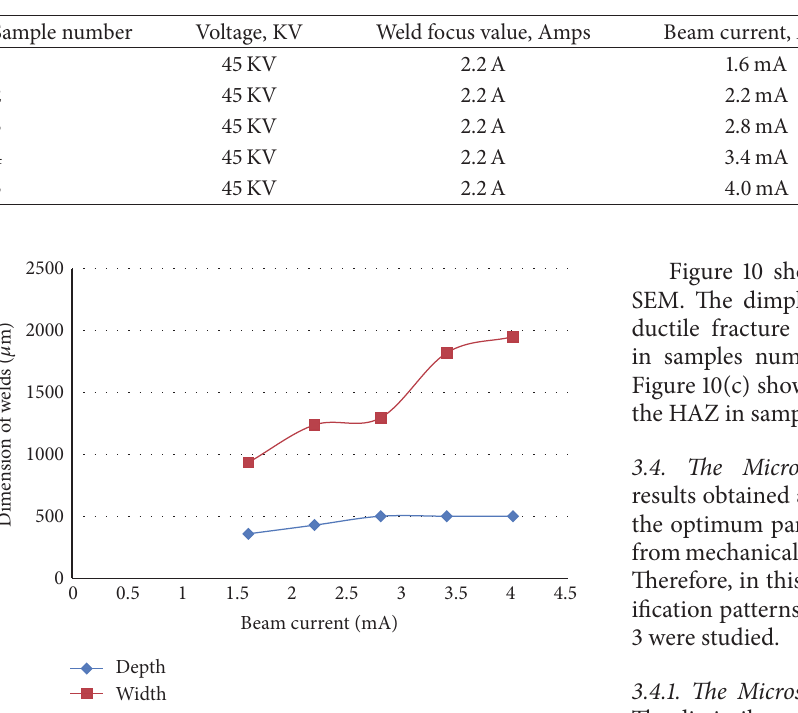
reason can be attributed to producing coarse grained soften- ing zone in the HAZ near the fusion boundary, according to Figure 17(b). The minimum hardness occurred on HAZ sample number 5. This is attributed to the beam current value in this sample which is the highest among all